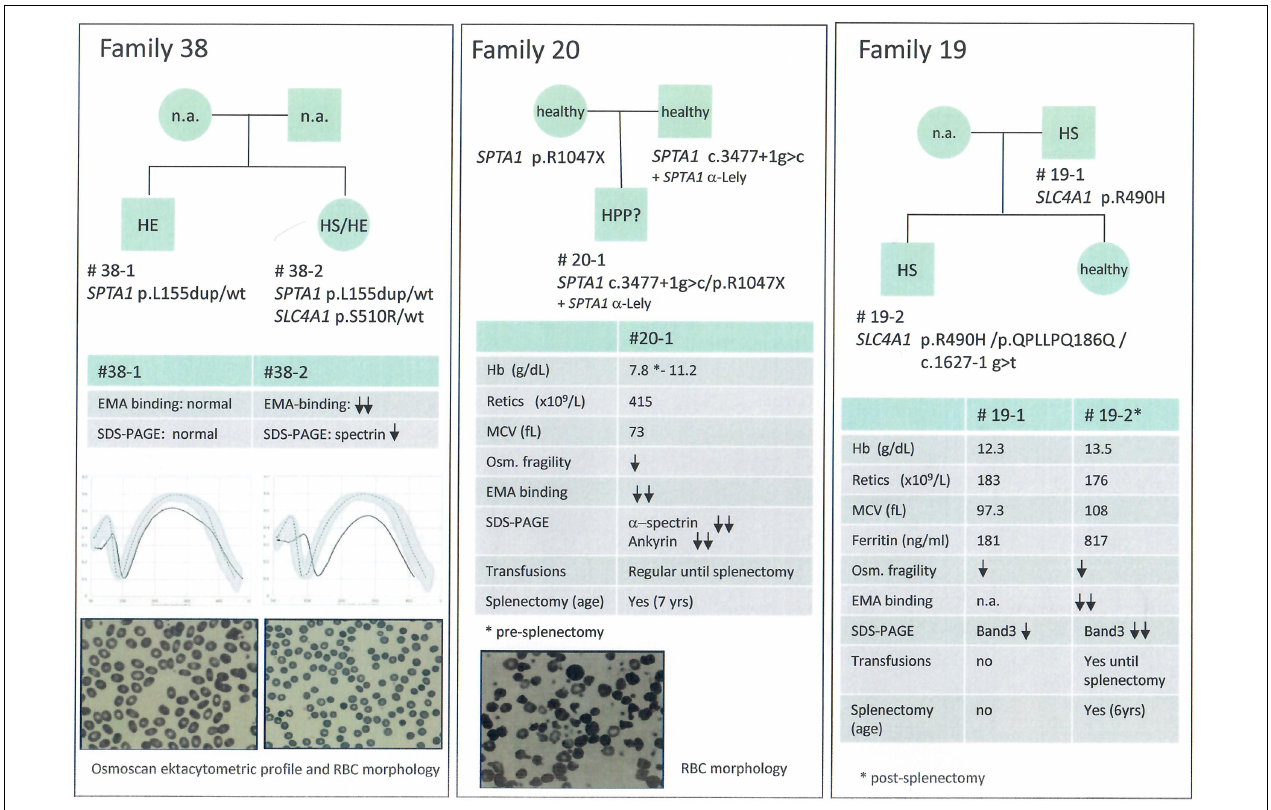
FIGURE 2 | Families with erythrocyte membrane defects and complex phenoptypes and/or intrafamily